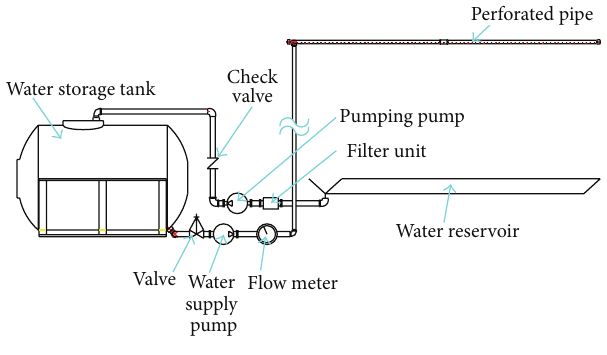
Figure 3: Water circulating